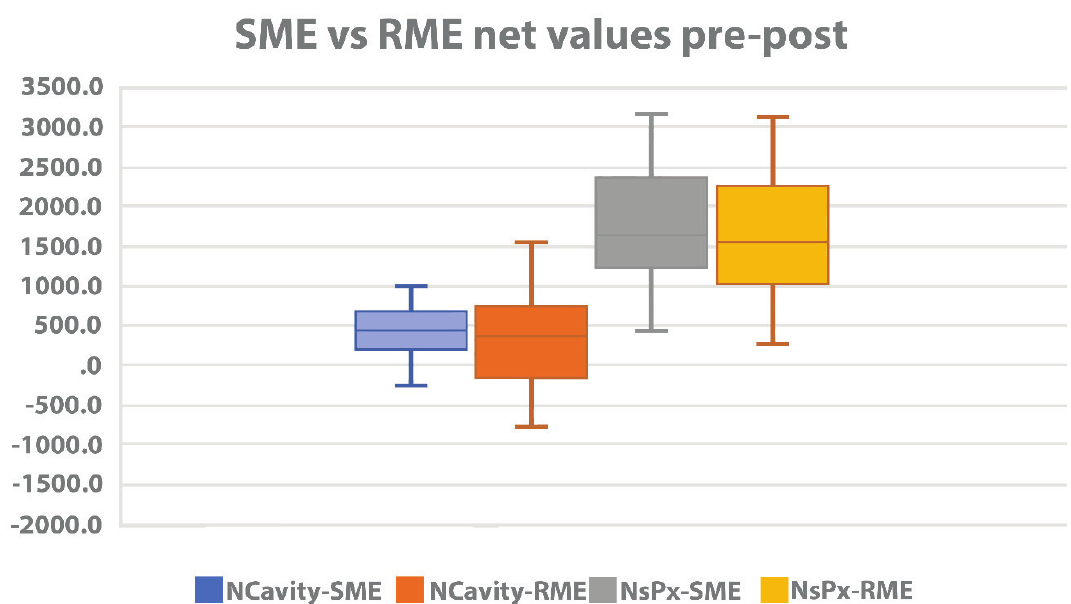
Figure 3. Boxplot comparing net values of mean, interquartile range, and data range of nasal cavity